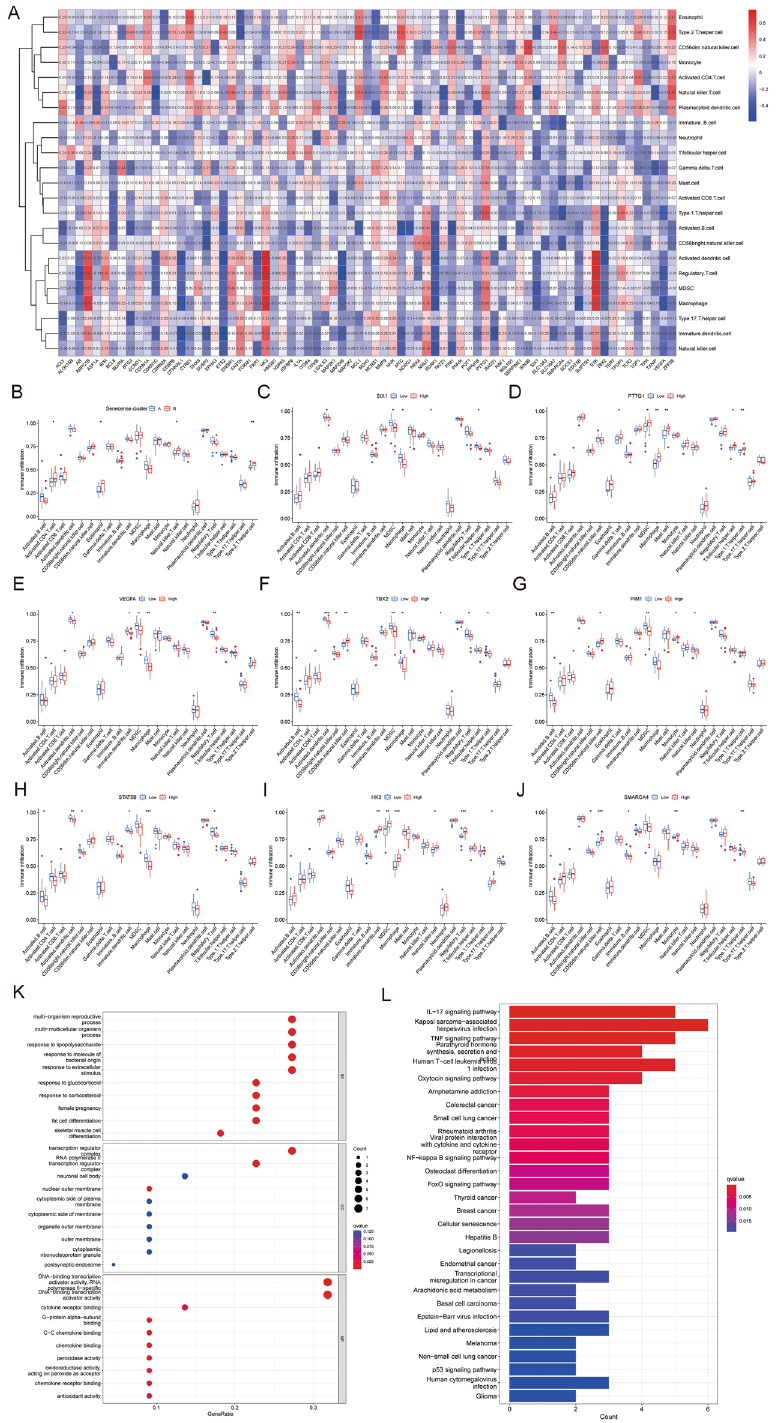
Figure 4. Immune cell infiltration and function enrichment analyses. ( A ) Heatmap showing the correlation between the expression of the 73 senescence regulators and immune cells infiltration using the ssGSEA method. ( B ) Boxplot showing the infiltrating immune cells in the two senescence clusters. ( C – J ) Correlation between key genes (SIX1, PTTG1, VEGFA, TBX2, PIM1, STAT5B, HK3 and SMARCA4) and immune cell infiltration. (K) The bubble diagram showing the top 10 terms of GO categories of BP, MF and CC. ( L ) Barplot diagram showing the KEGG enrichment analysis. (All figures *represents p < 0.05, **represents p < 0.01, ***represents p < 0.001) ssGSEA, single-sample gene-set enrichment analysis; GO, gene ontology; KEGG, Kyoto Encyclopedia of Gene and Genome; BP, biological process; MF, molecular function; CC, cellular